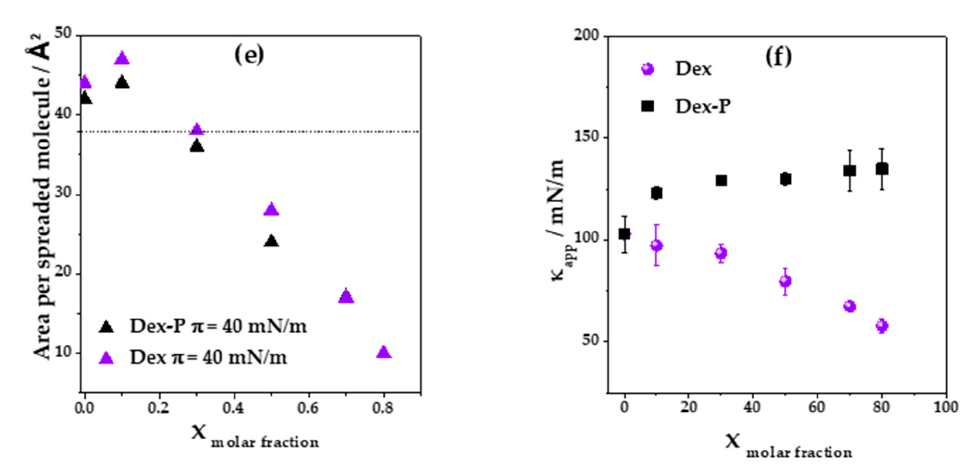
Figure 2. ( a , b ) Surface pressure – area per spreaded molecule compression isotherm and ( c , d ) Com- pressibility coefficient ( κ app ) as function of the surface pressure for DMPC: X mixtures; were X: Dex ( a – c ) and Dex-P ( b – d ). DMPC: X molar fraction; 1:0 (black), 9:1 (red), 7:3 (green), 1:1 (blue), 3:7 (cyan), 2:8 (magenta). ( e ) Area per spreaded molecule and ( f ) compressibility coefficient ( κ app ) at π = 40 mN/m, as function of Dex (violet) or Dex-P (black) molar fraction obtained from ( a – d ). Experimental conditions: 150 mM NaCl, isotherm compression rate 5 mm/min, T: 15 °C.